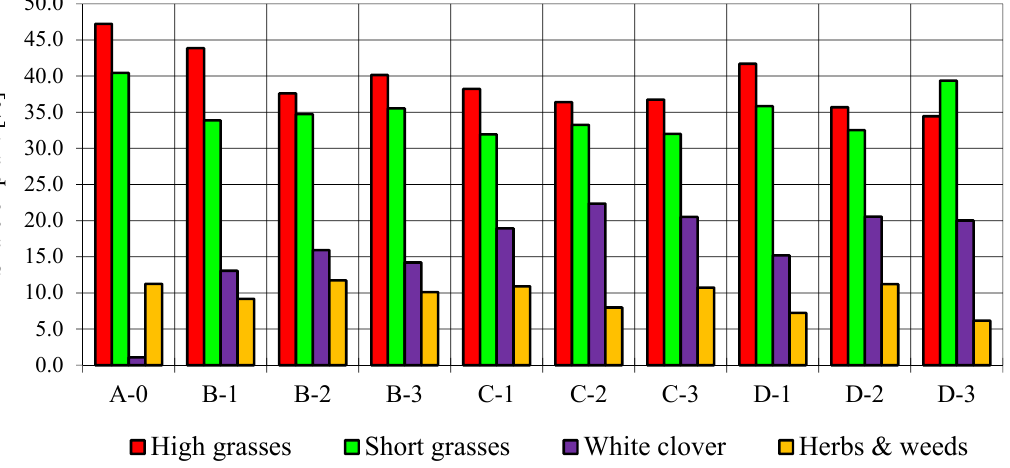
Figure 9. The mean share of plant groups in % of ADM in 1st pasture rotation (Years 2012–2019). Tillage treatments: A—control object (without overseeding), B—underseeding after heavy tine harrow, C—underseeding after disc harrow, D—underseeding after the rotary tiller. During the first pasture rotation, the ADM’s yield followed a second-degree